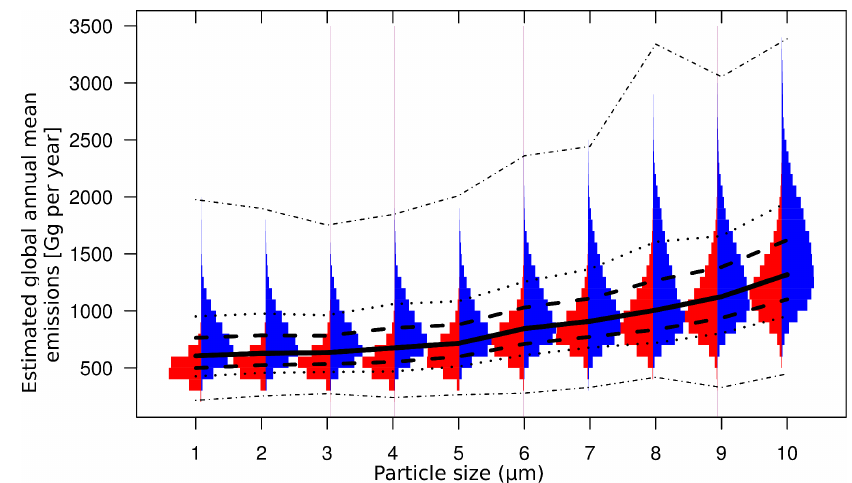
Fig. 5. Distributions of global annual mass emissions estimates [Gg per year] shown as histograms. Results are shown from left to right for each particle diameter from 1µ m to 10µ m , and for CCN-INACTIVE (red, on left for each size) and CCN-ACTIVE (blue, on right) particles. Lines demarcate the minimum, 10-%ile, 25-%ile, 50-%ile, 75-%ile, 90-%ile, and maximum of the total sample (CCN-ACTIVE and CCN-INACTIVE particles combined) for each particle size. Results are for PRIOR-POS.